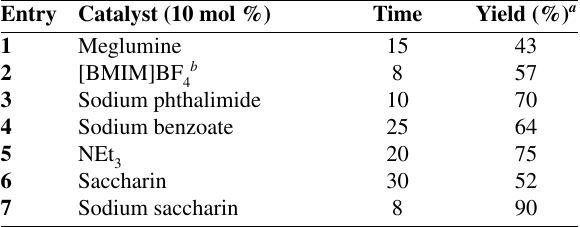
Table 5 . The effect of various catalysts on the synthesis of 4a under optimized conditions Entry Catalyst (10 mol %) Time Yield (%)